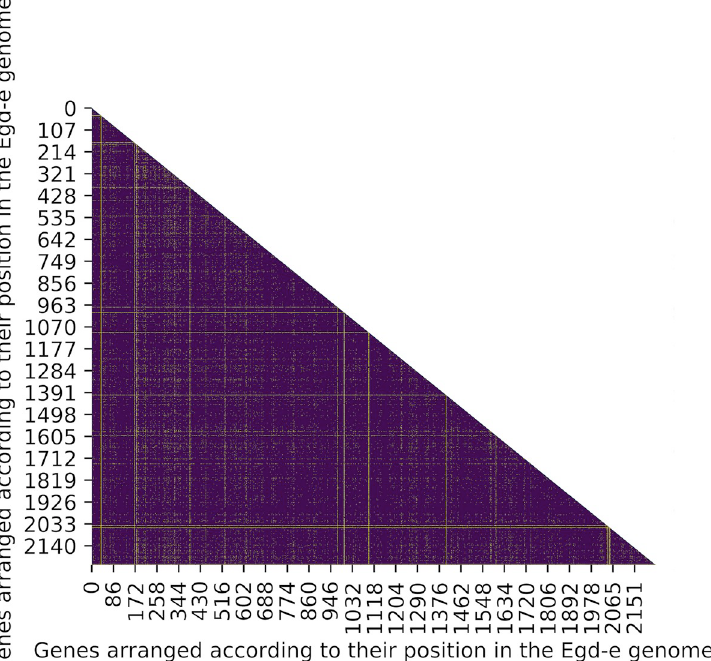
Fig 2. Heatmap of the extent of LD in the genome of L . monocytogenes . Genes are ordered according to their genomic positions in the L . monocytogenes reference strain EGD-e along the x and y axis (for gene names see S4 File). A majority of genes show significant LD in the genome (indigo), while few genes are at linkage equilibrium (yellow).